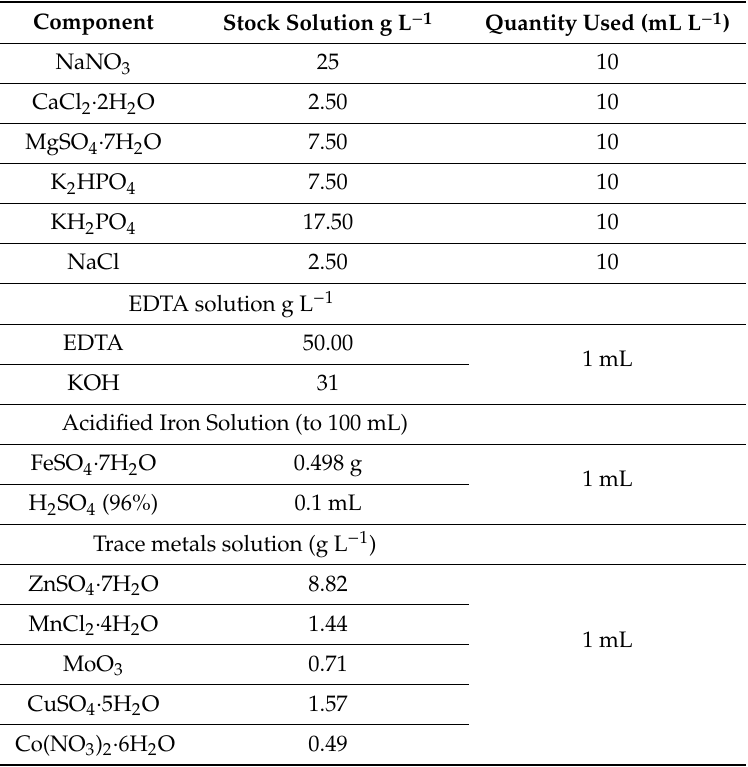
Table 5. Composition of of Bold Basal